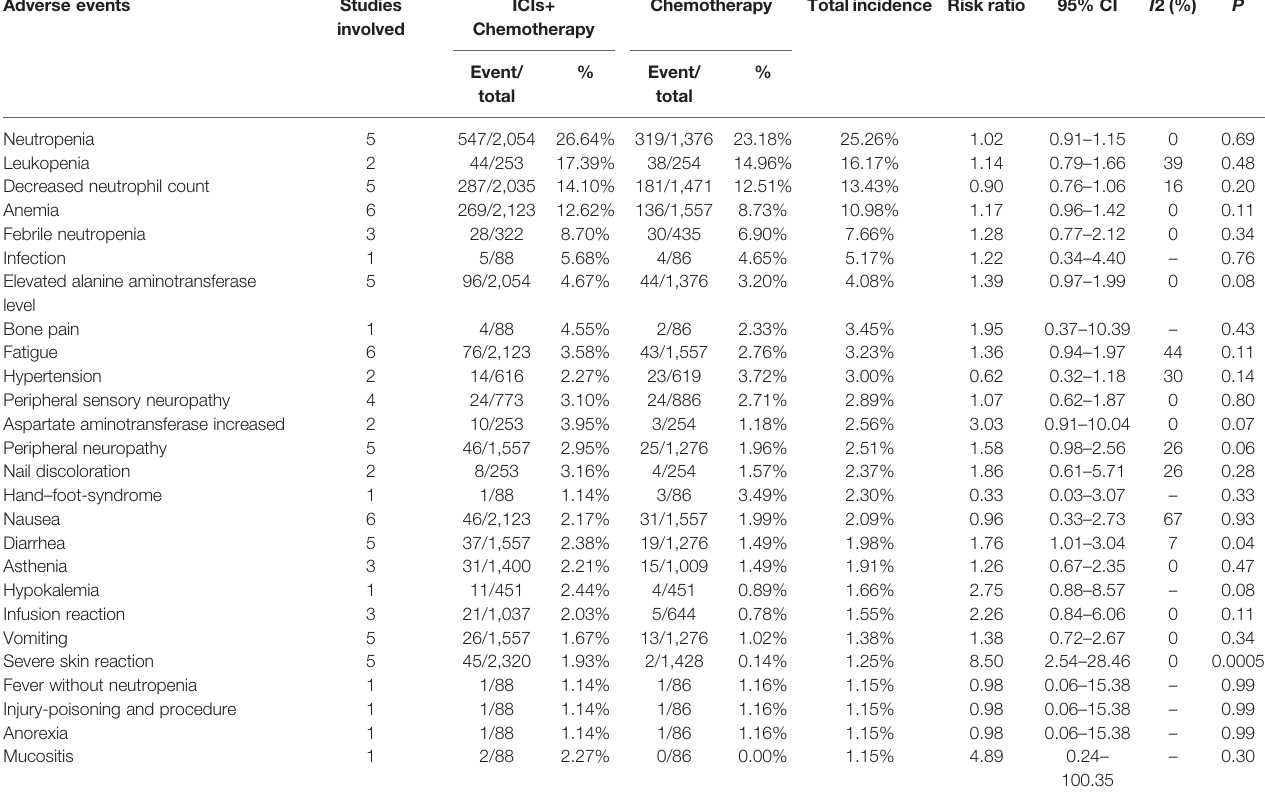
TABLE 5 | Grade 3 – 5 adverse events an incidence of more than 1% according to combination of two